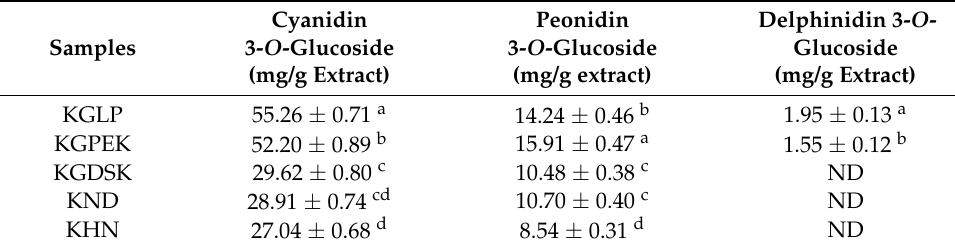
Table 1. Anthocyanin content of purple rice extracts.